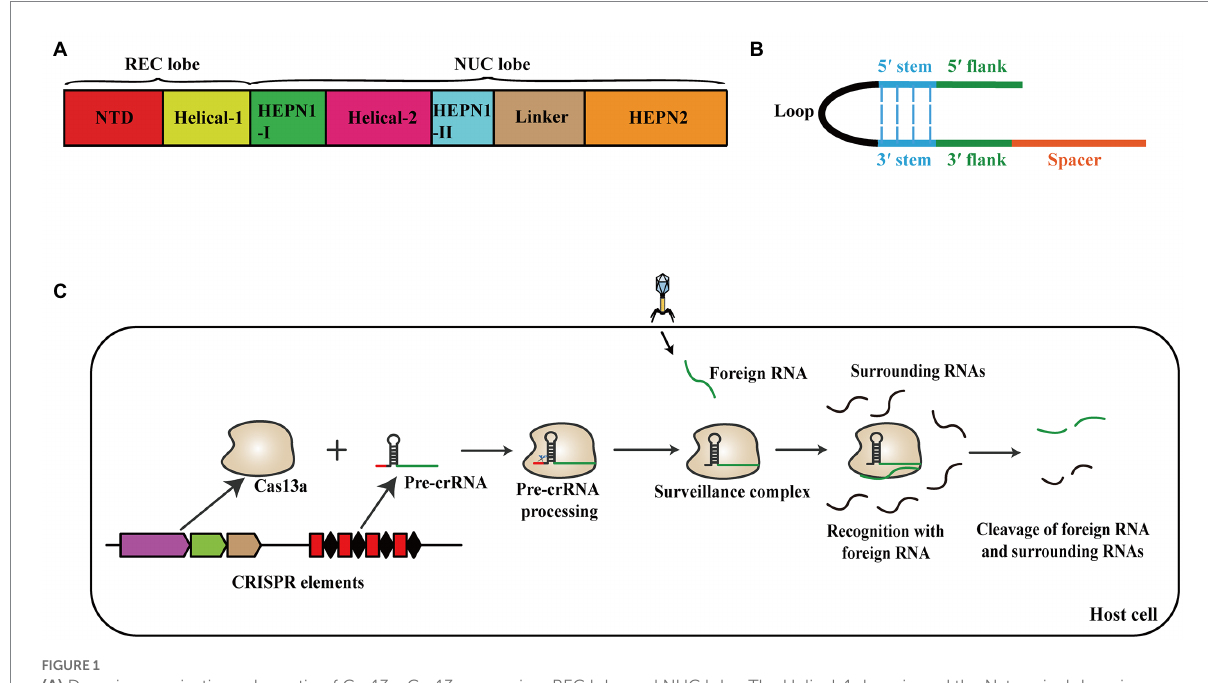
FIGURE 1 (A) Domain organization schematic of Cas13a. Cas13a comprises REC lobe and NUC lobe. The Helical-1 domain and the N-terminal domain constitute REC lobe, the NUC lobe contains the HEPN1 domain, HEPN2 domain, Helical-2 domain, and a Linker. (B) Schematic representation of the mature crRNA structure. The mature crRNA contains 3 ′ spacer and 5 ′ handle, which consists of 5 ′ flank, 5 ′ stem, Loop, 3 ′ stem, and 3 ′ flank. (C) Schematic of the effect mechanism of Cas13a system against foreign nucleic acid. Cas13a processes pre-crRNA into mature crRNA independently and combines with its crRNA to form the surveillance complex that recognizes the foreign target RNA and cleaves the target and surrounding